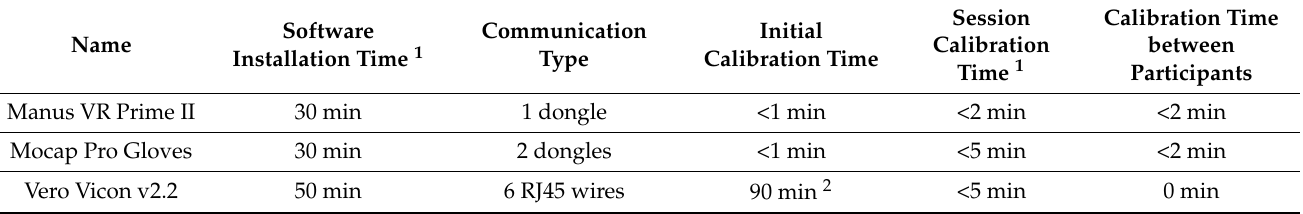
Table 2. Comparison of the installation and setting up